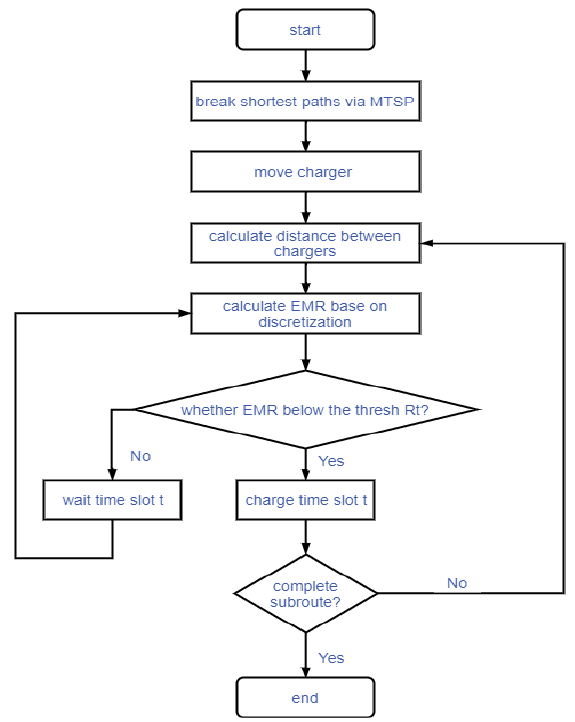
Figure 14. The flowchart of non-partition algorithm.